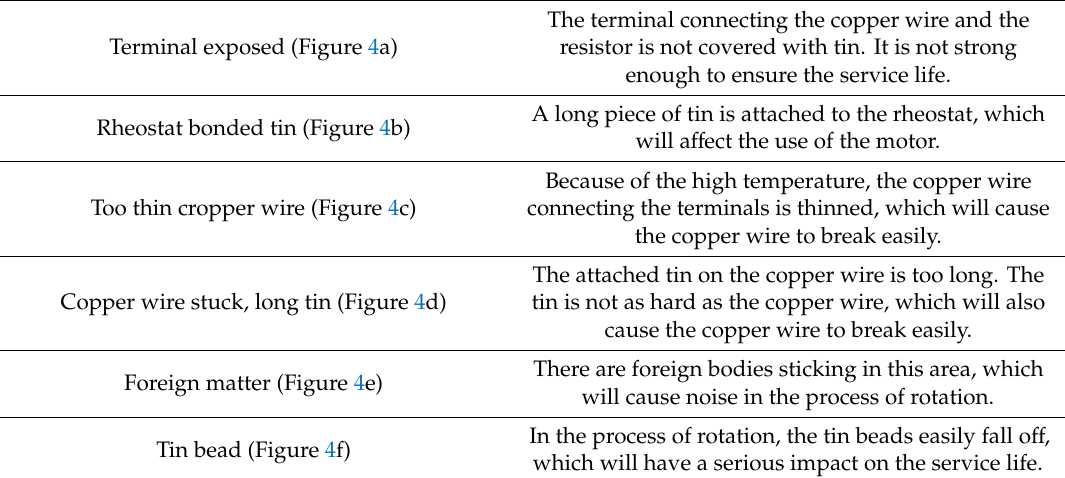
Figure 4. The final inspected area in our study and some of the surface defects. Table 1. Types of surface